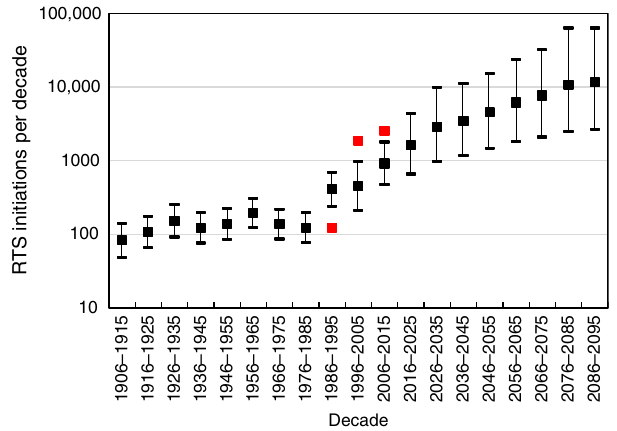
Fig. 9 Modelled decadal retrogressive thaw slump initiation rates for Banks Island (1906 – 2015) and multimodel mean predictions under RCP4.5 (2016 – 2095). Red squares are observations based on the Timelapse data. Error bars for hindcast modelling generated using the Hadley CRU dataset 52,53 are 95% con fi dence intervals. Values in the fi rst two decades are affected by constant values appearing in the dataset for the northern part of the island. Future modelled mean and error bars are averages of 100 sets of predictions made with the best- fi t relation in Fig. 2d and with 95% con fi dence